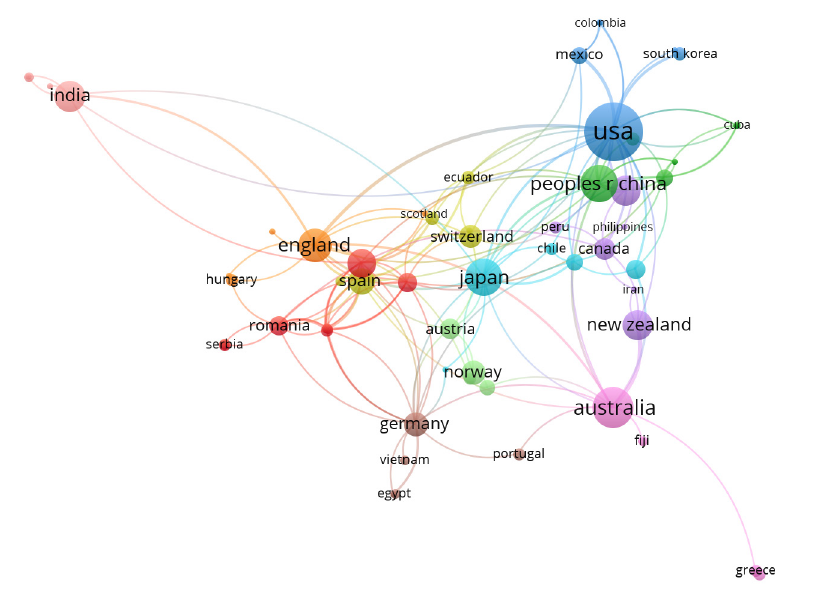
Figure 4. Country/Region collaboration